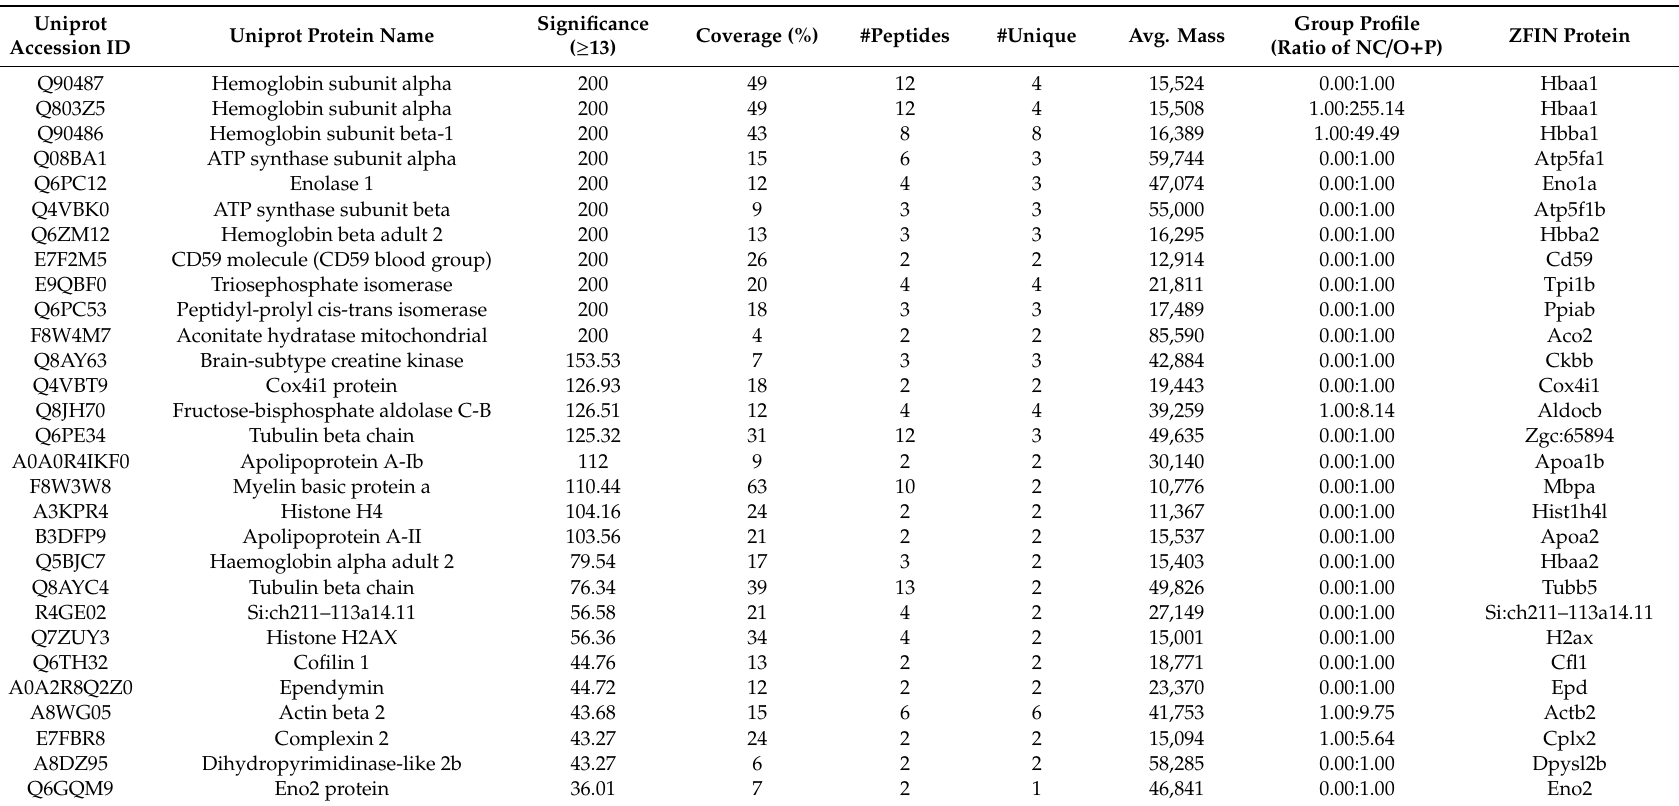
Table 4. Di ff erentially expressed proteins identified from negative control (NC, PTZ 170 mg / kg only) and O + P (OSLP 800 µ g / kg + PTZ 170 mg / kg) zebrafish